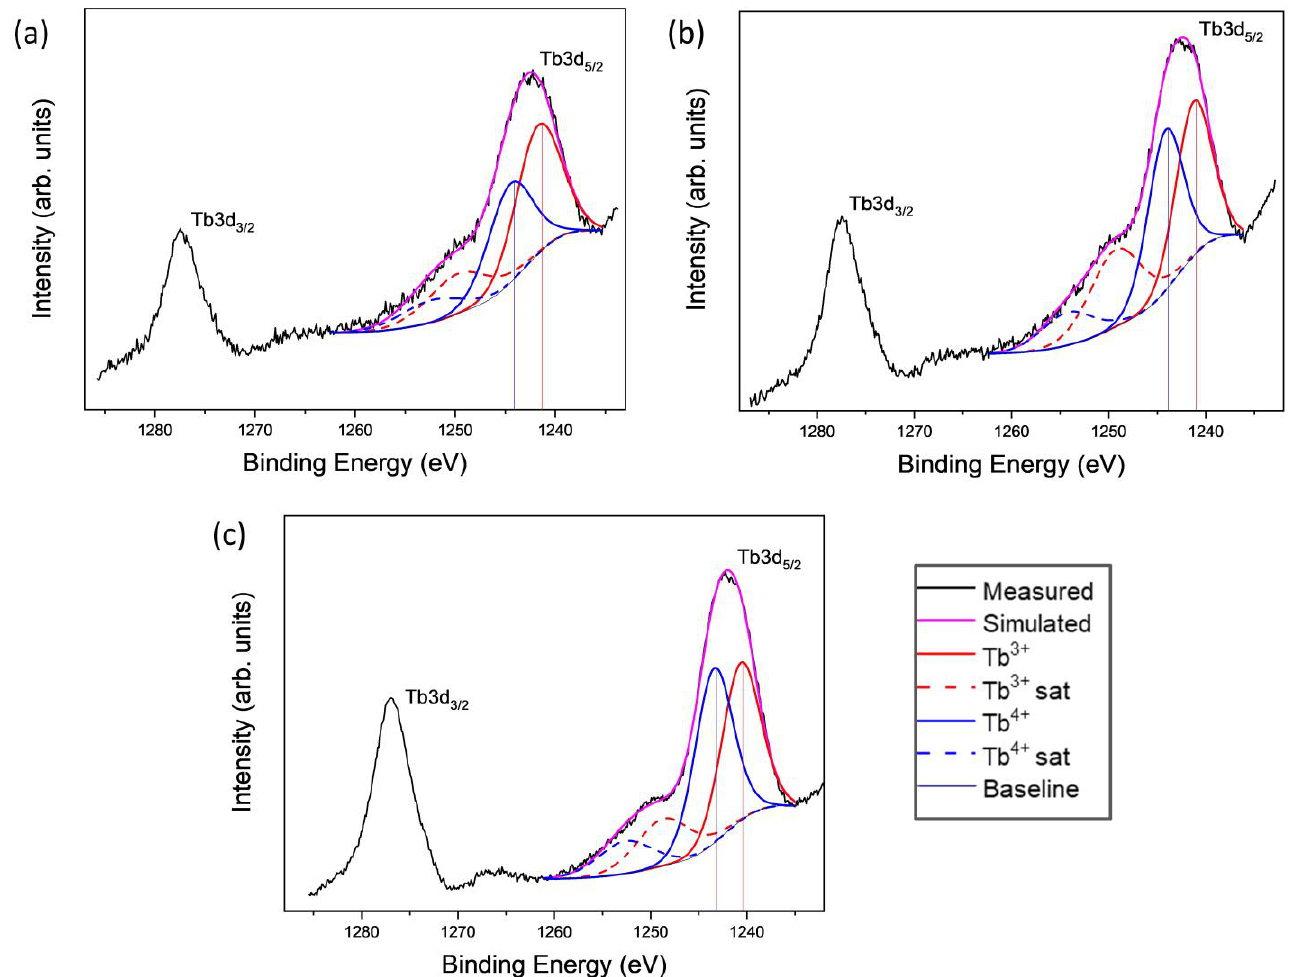
Figure 9. Experimental and fitted Tb 3d 5/2 X-ray photoelectron spectral region for selected samples 3.00%_550 ( a ), 1.70%_800 ( b ), and 1.70%_1000 ( c ). Vertical lines are added for easy reading of the peak values on the X-axis. Table 3. Quantitative analysis of the deconvolution of Tb 3d 5/2 signal with two components: Tb 3+ and Tb 4+ (a) and quantitative analysis of the deconvolution of X-ray photoemission O 1s signal with two components (b) : Ti-O lattice and Ti-OH terminal (at.%: percentage of atomic concentration). Tb 4+ (a)